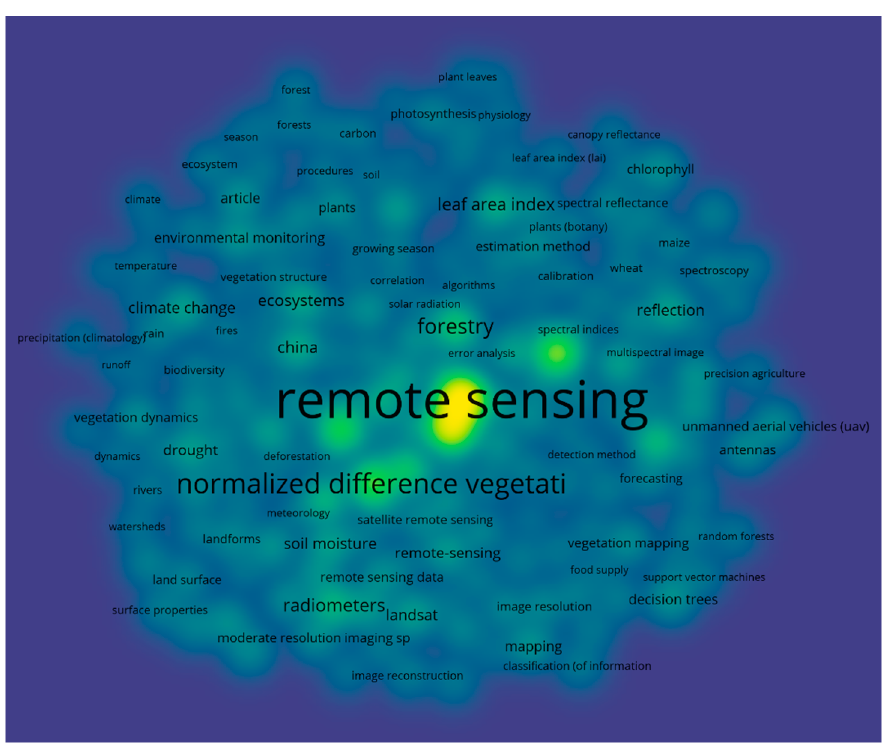
Figure 3. Keywords network found in Scopus searching with remote sensing and vegetation. Graph elaborated with VOSviewer.